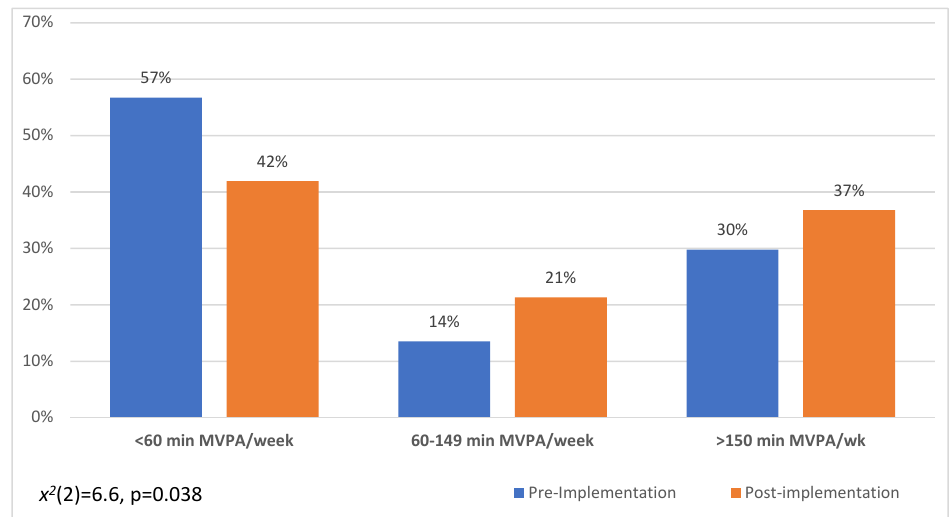
Figure 4. Moderate-to-Vigorous Physical Activity (MVPA).